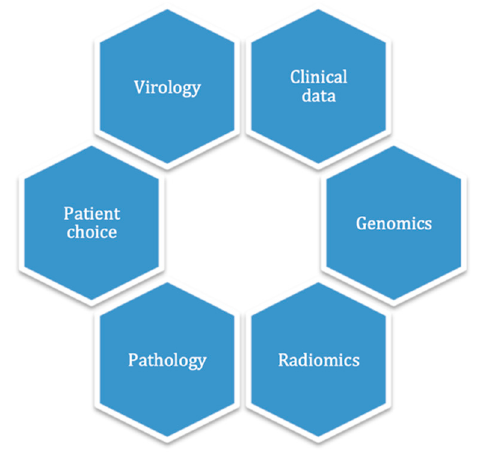
Figure 2. The “holistic flower” of decision-making for ASCC .